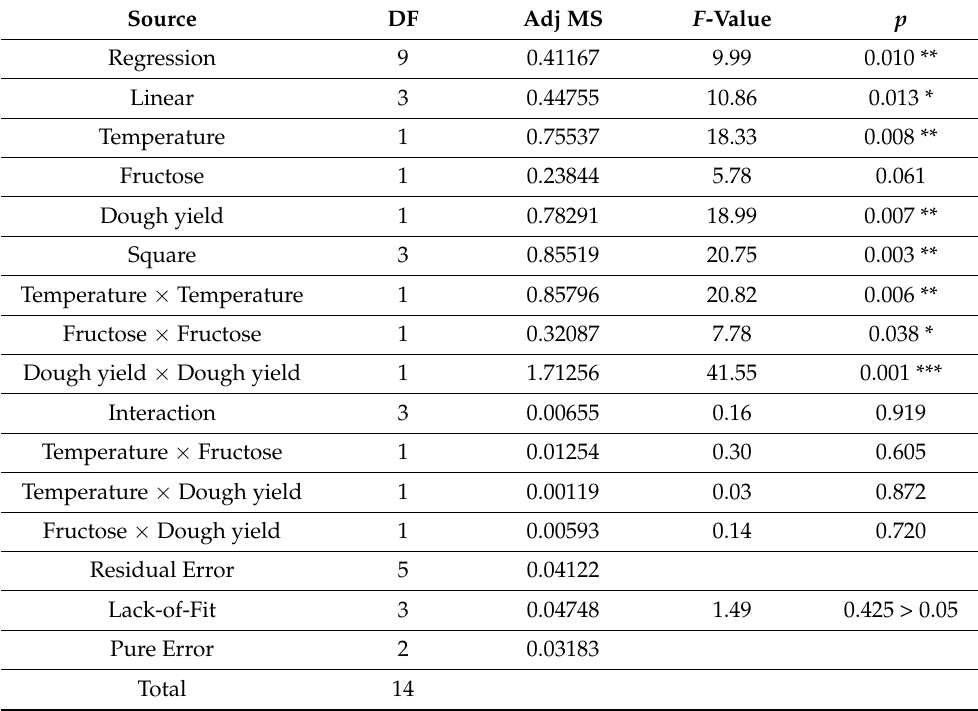
Figure 2. Optimization of conditions for TEAC of sourdough fermentation using response surface methodology (RSM). Contour plots of ( A ) fructose vs. temperature, ( B ) dough yield vs. fructose, and ( C ) dough yield vs. temperature. Surface plots ( D – F ) correspond to ( A – C ), respectively. Table 2. ANOVA of the response variables of the bread